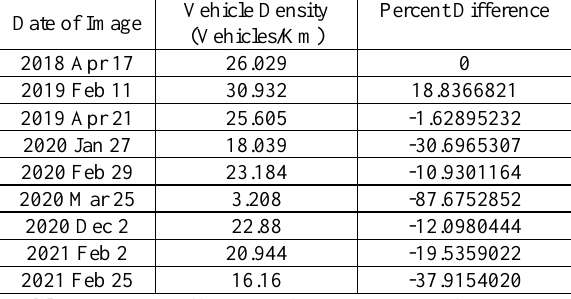
Table 4. Percent Differences of Vehicle Density from EDSA- Triangle